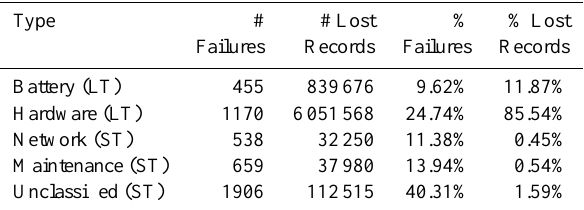
Table 2. Overall breakdown of failures by estimated type.